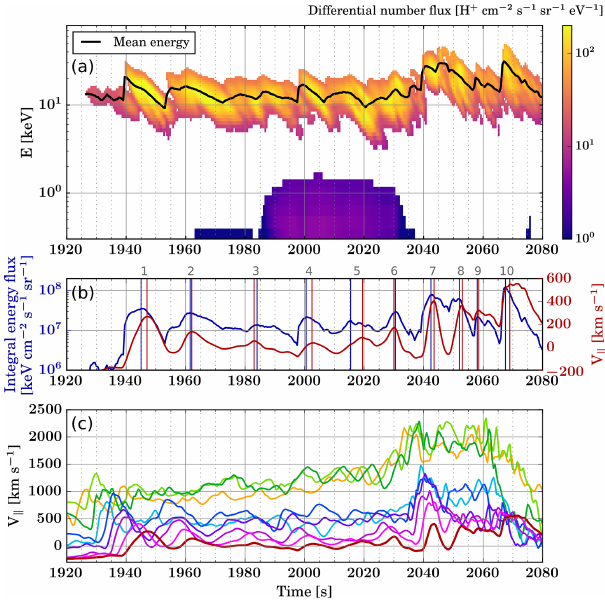
Figure 7. (a) Differential number flux of precipitating protons ob- served at virtual spacecraft S 1 between t = 1920 and t = 2080s. The black line indicates the mean precipitating energy as a function of time. (b) Blue line: integral energy flux associated with proton precipitation as a function of time at virtual spacecraft S 1 . Red line: parallel component of the plasma bulk velocity at S 1 . The vertical lines indicate the times associated with peak values for these two parameters, and the numbers in grey above the panel identify the precipitation bursts discussed in the text. (c) Parallel component of the plasma bulk velocity at S 1 and at the virtual spacecraft indicated with plus signs in Fig. 6, with a consistent colour